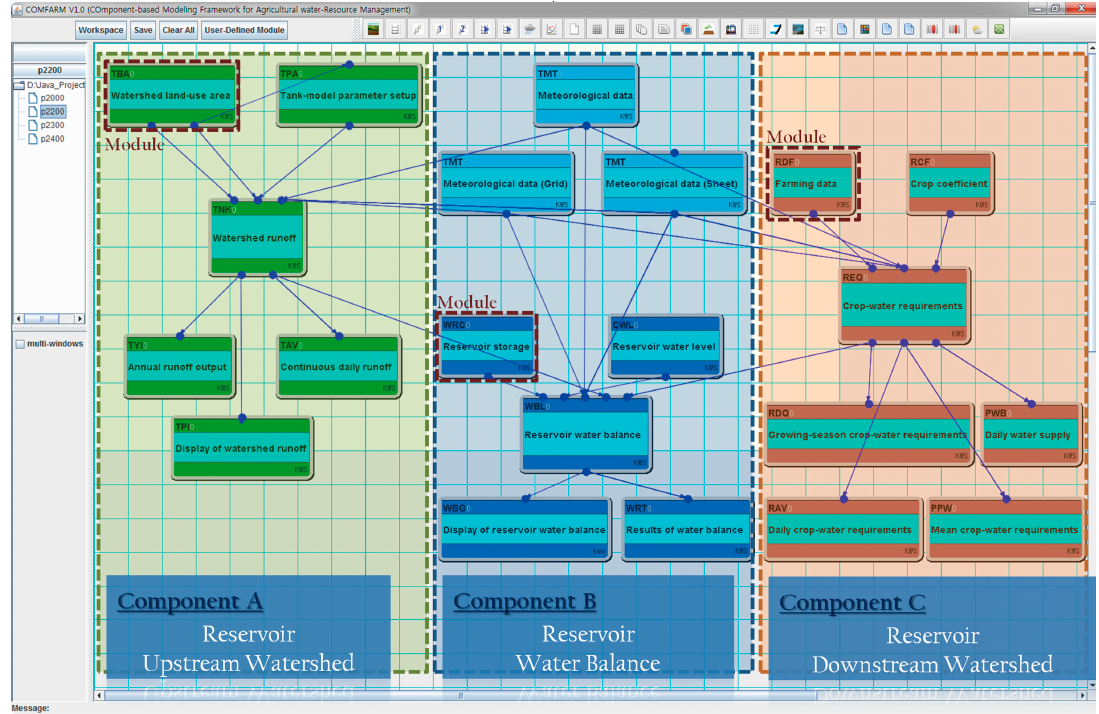
Figure 5. Modeling system linked by components with object-oriented modules for water-cycle analysis at the watershed scale.